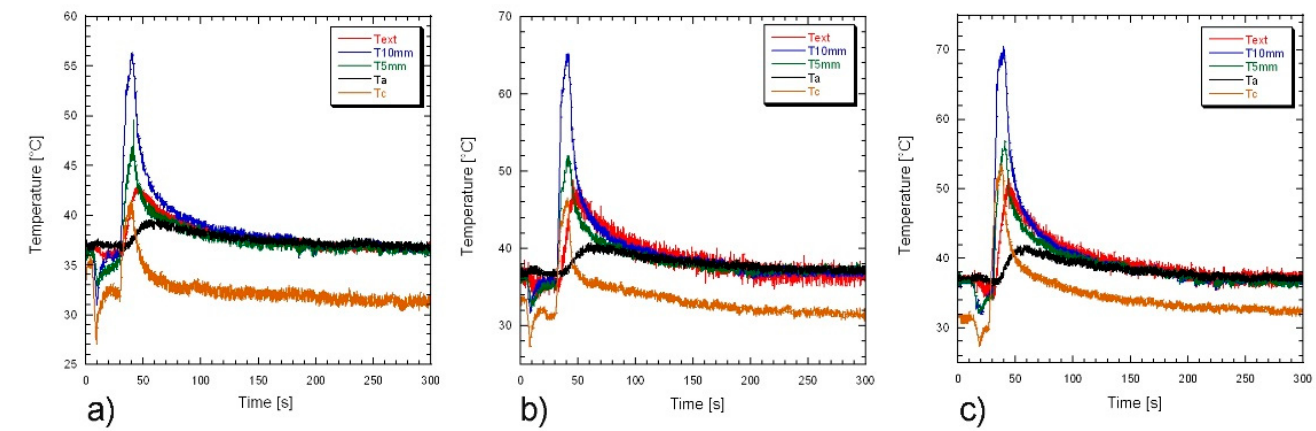
Figure 4. Temperature profiles in different regions of the tooth by heating sodium ‐ hypochlorite through the F ‐ 06 plugger using temperature set at 100 °C ( a ), 150 °C ( b ), and 180 °C ( c ). 3.2.2. XF-30/04 Plugger